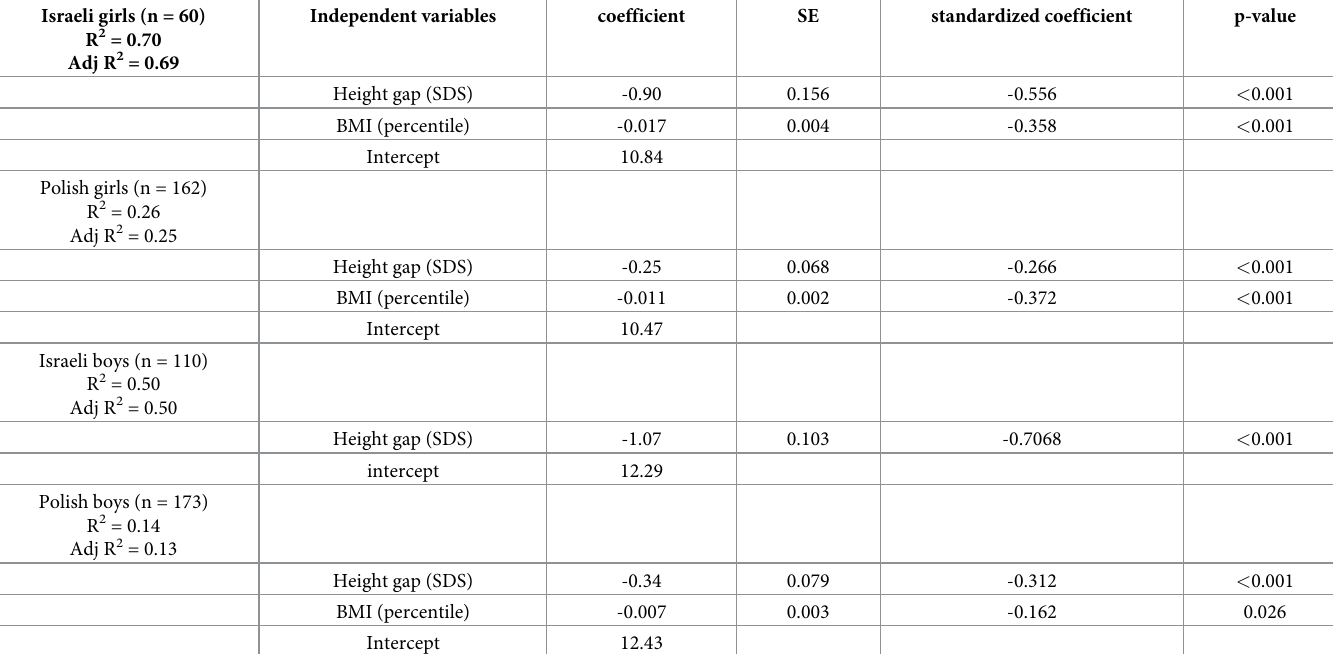
Table 2. Results of the regression analysis of the onset age of puberty with the height gap and the BMI percentiles. Israeli girls (n = 60) R 2 = 0.70 Adj R 2 = 0.69